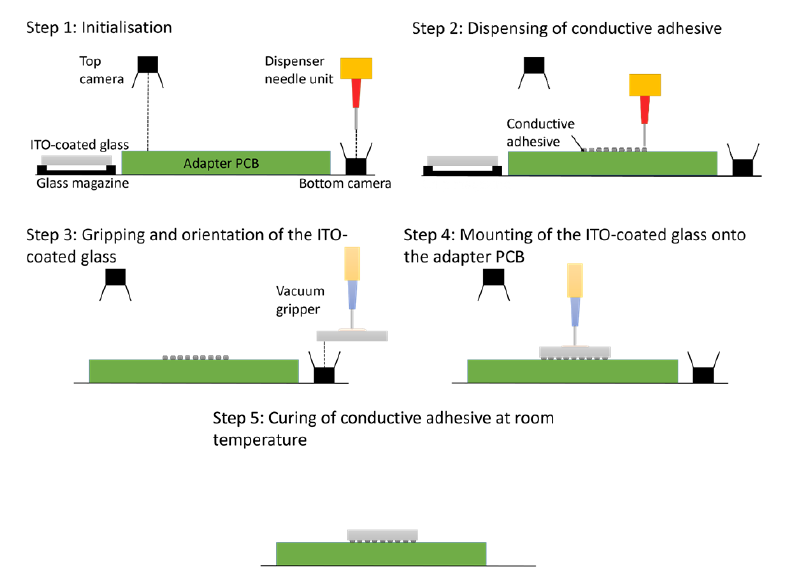
Figure 16. Process for automatic mounting of ITO-coated glass onto an adapter PCB with a four-axis handling system using image processing, adapted adhesive dispensing and vacuum